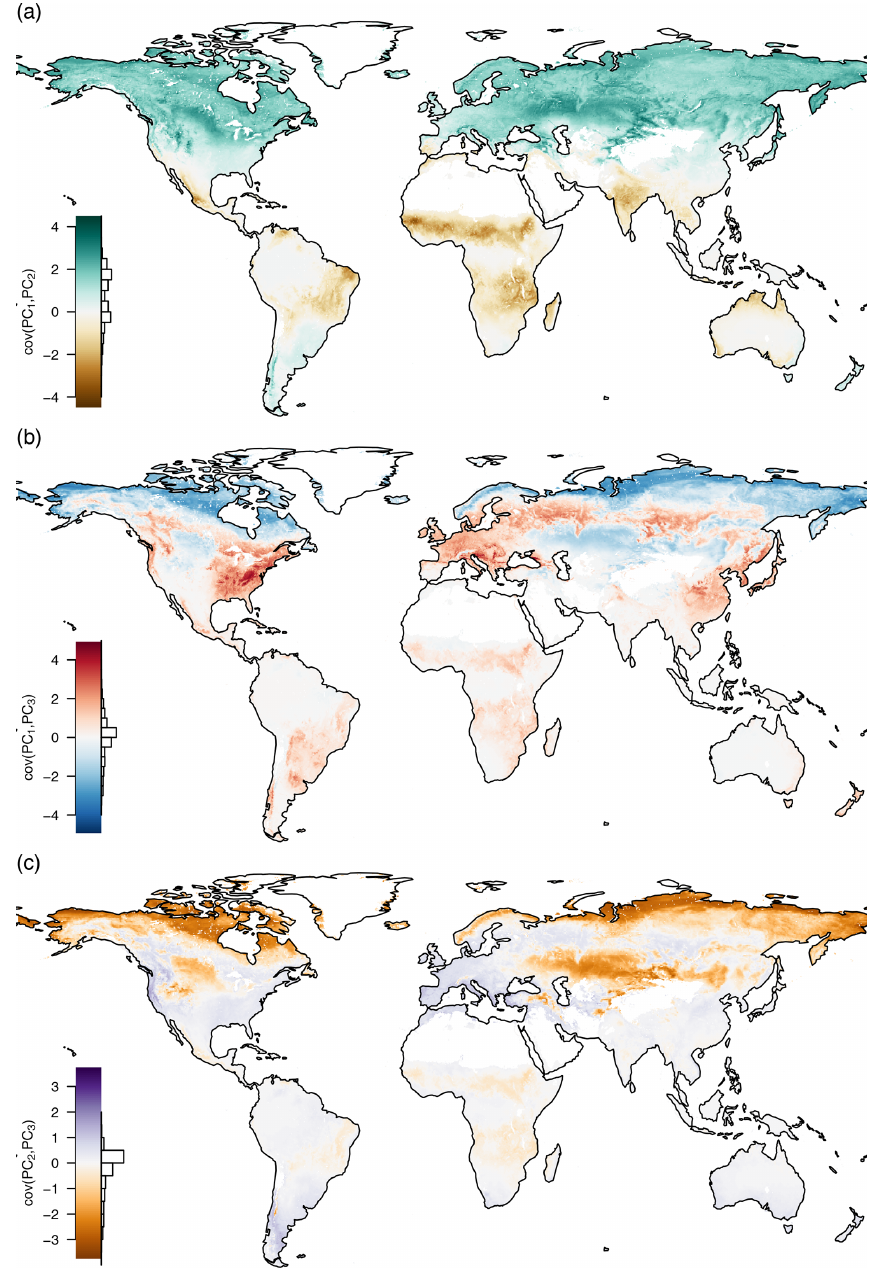
Figure D1. Pairwise covariances of the first three principal components mean seasonal cycles by space. (a) cov ( PC 1 , PC 2 ) , (b) cov ( PC 1 , PC 3 ) , and (c) cov ( PC 2 , PC 3 ) . The bar charts show the distribution of the covariances. It can be seen that although two principal components are globally uncorrelated by their way of con- struction, they covary